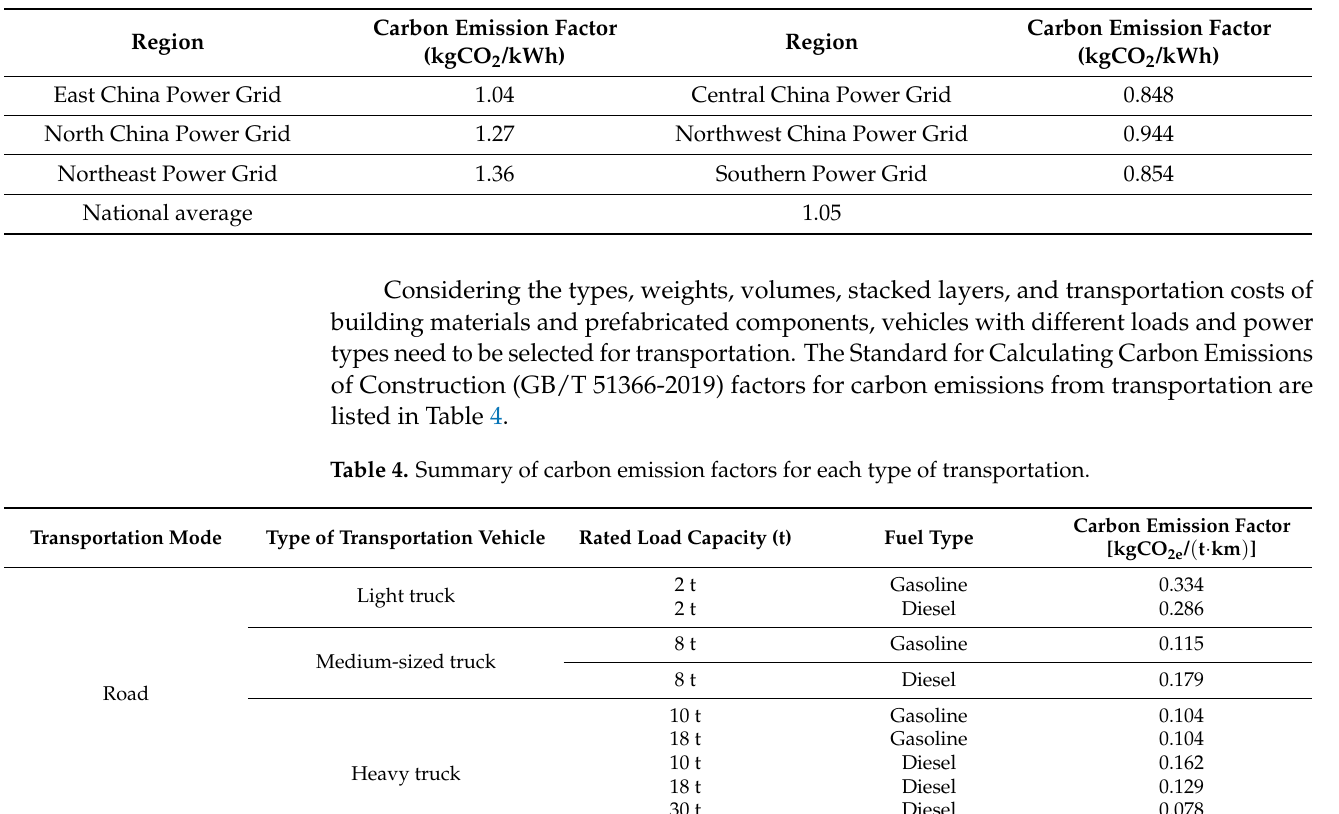
Table 3. Table 3. Summary of carbon emission factors of electric energy.